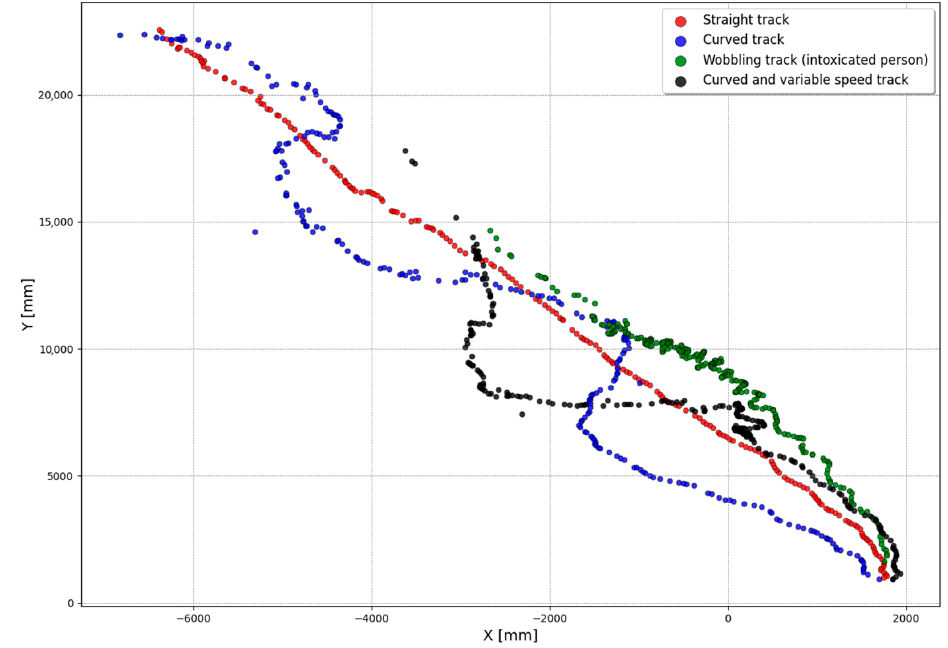
Figure 12. Examples of four different kinds of tracks captured by the 3D Video in BCT test runs. Data captured at Anagnina using the 3D Video system on 1–19 April 2022 demon- strates that BCT test runs have had commuter speeds close enough to real-life